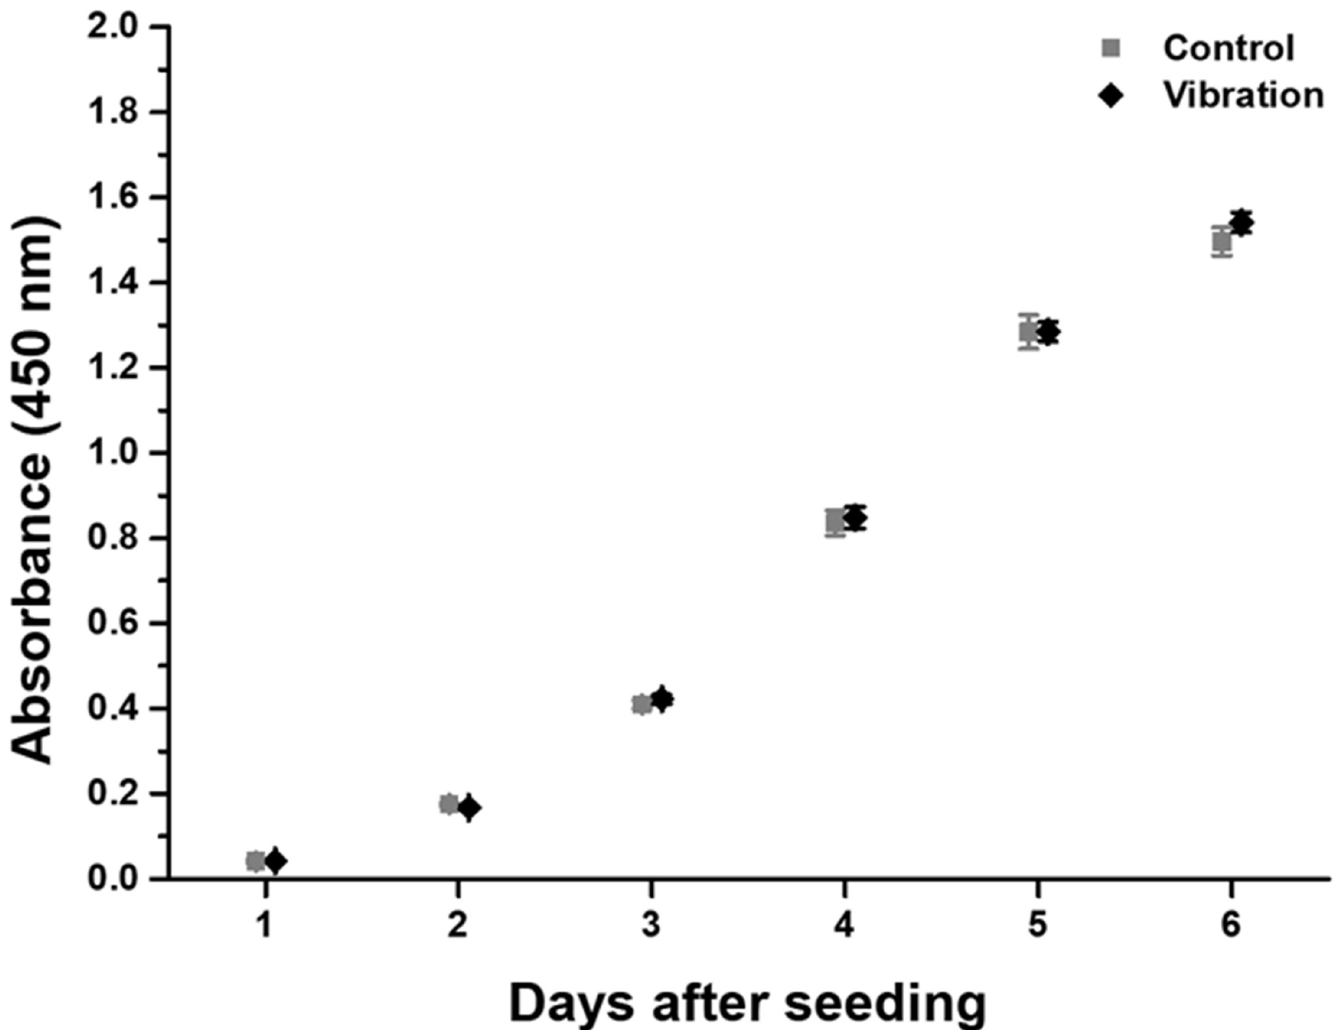
Fig 4. Cell proliferative activity as assessed by the CCK-8 assay. Every 24 h until the last absorbance measurement, absorbances at 450 nm were measured. The HaCaT cells were initially exposed to mechanical vibration for 2 h ( n =